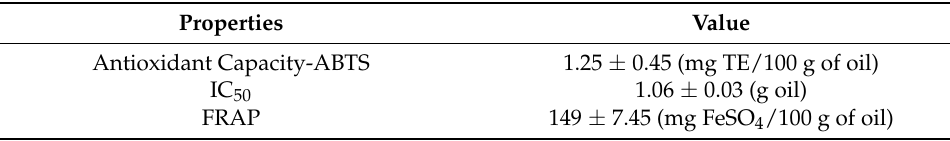
Table 4. Antioxidants capacity in Mayten tree seed oil.